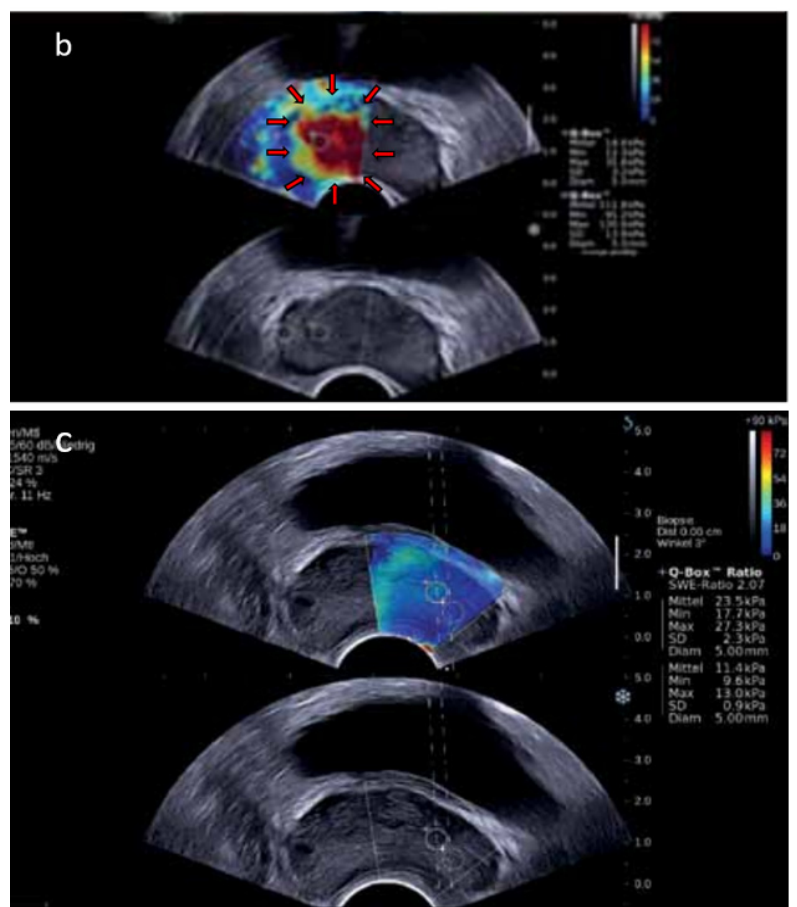
Figure 4. SWE images: ( a ) prostate with a small hard lesion (kPa value: 62) in the peripheral zone (arrows); ( b ) prostate with a huge area of very hard tissue (kPa value: 111), highly suspicious (arrows); and ( c ) prostate with no hard tissue and no evidence of tumor. Images provided courtesy of SONOlife.